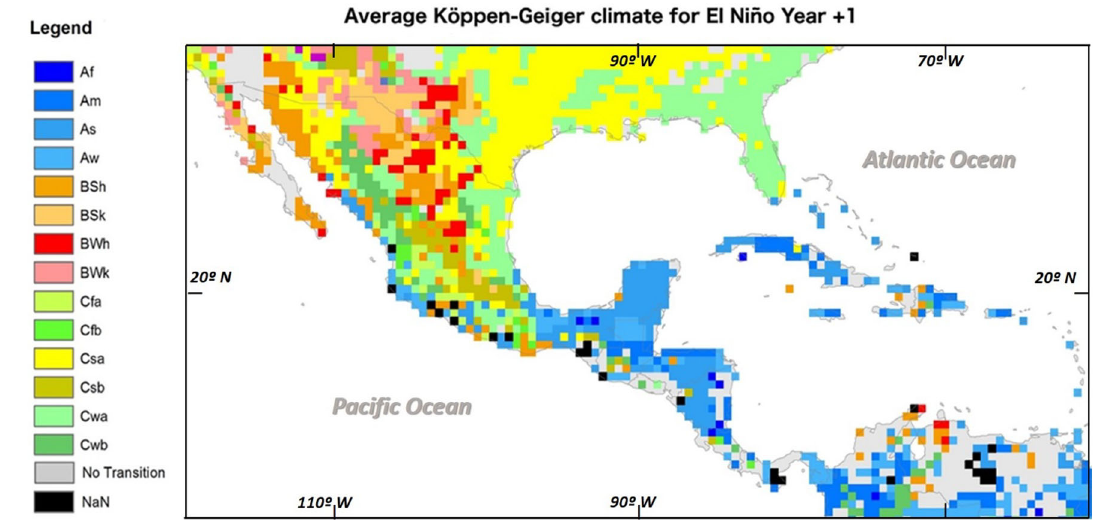
Fig. 6 Ko¨ppen–Geiger climate classification during El Nin ˜ o Year ? 1 based on five strong El Nin ˜ os in the Central American and circum- Caribbean region